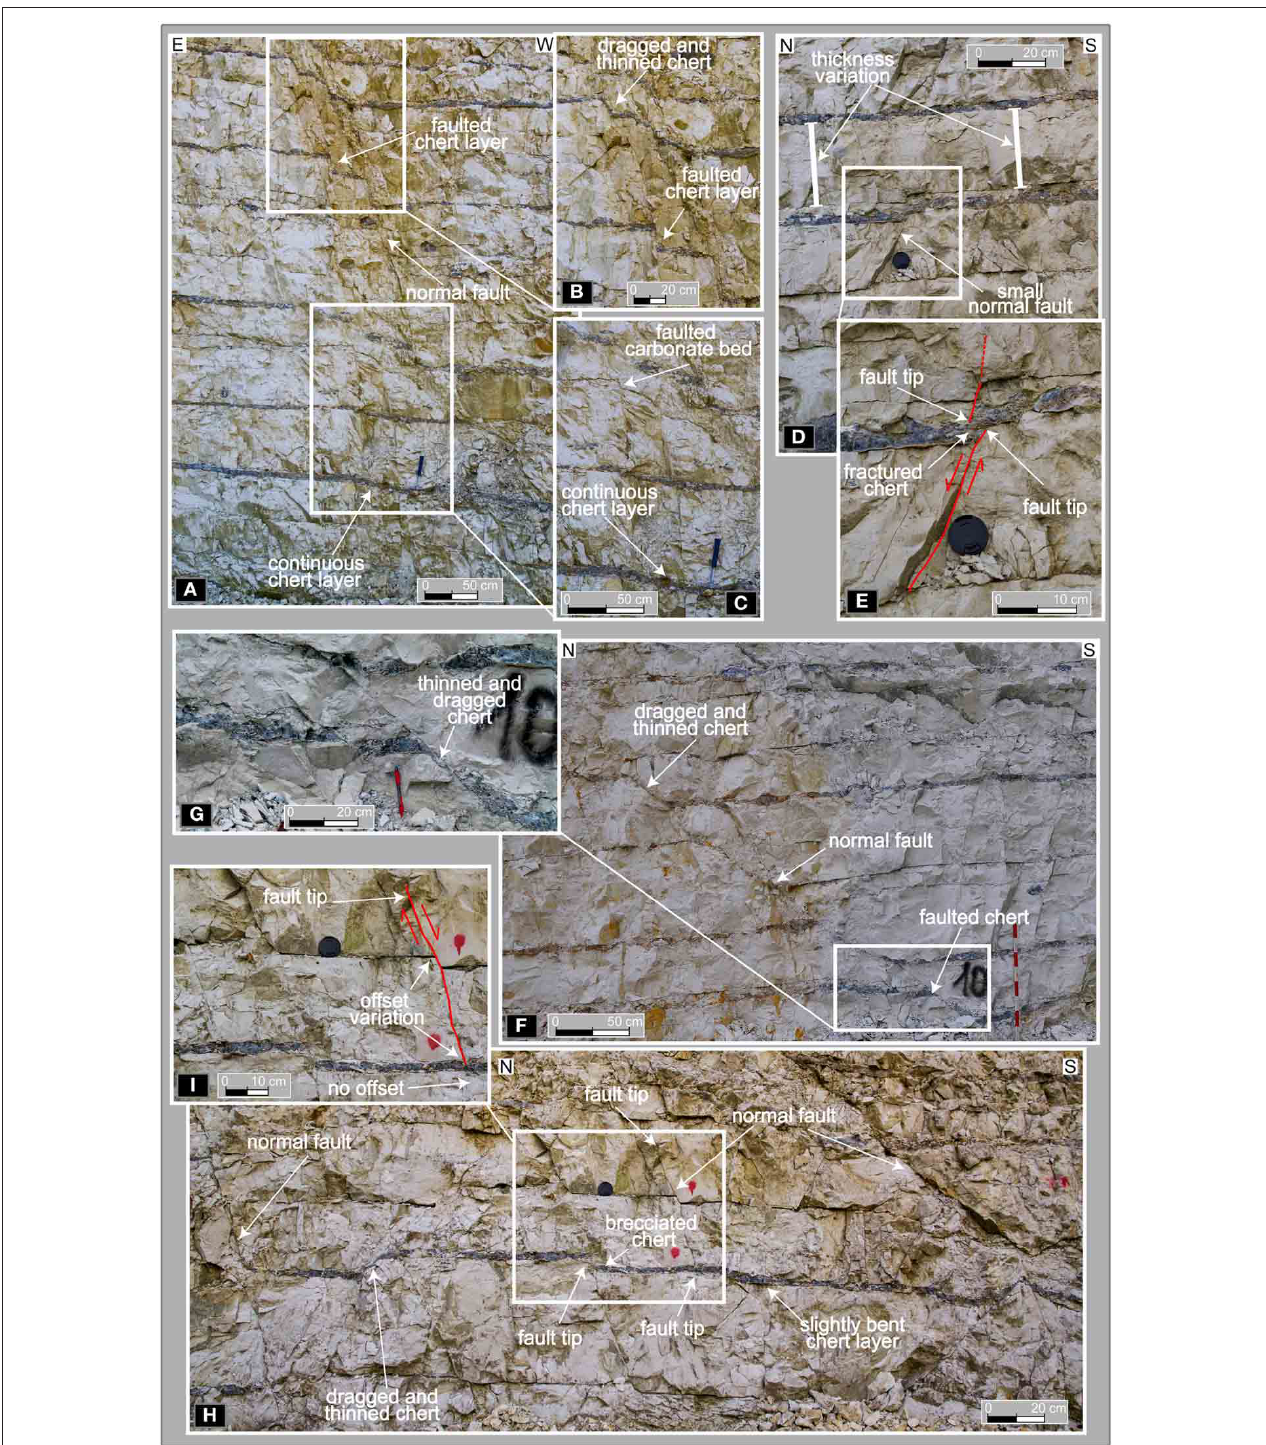
FIGURE 5 | Exposure photographs (Scaglia Bianca Fm.). (A) Normal faults across alternate carbonate-chert beds. (B,C) Enlargements from the previous photograph. Note that the faults cut through the carbonate beds, but generally do not offset the chert layers, which are bent, dragged, and thinned over the fault surface. The fault offset fades away moving downdip where a chert layer is slightly bent. (D) Normal fault across carbonate-chert beds. Note the lateral variation of carbonate bed thickness. (E) Enlargement from the previous photograph. Note the small fault displacement that fades away updip and the fault step corresponding to the intersection with a chert layer that is slightly bent. (F) Intermediate-angle normal fault across carbonate-chert beds. (G) Enlargement from the previous photograph. Note the thinning of the chert layer along the fault surface. (H) Normal faults across carbonate-chert beds. (I) Enlargement from the previous photograph. Note the faults abutting against the chert layers and the offset variation along the faults.